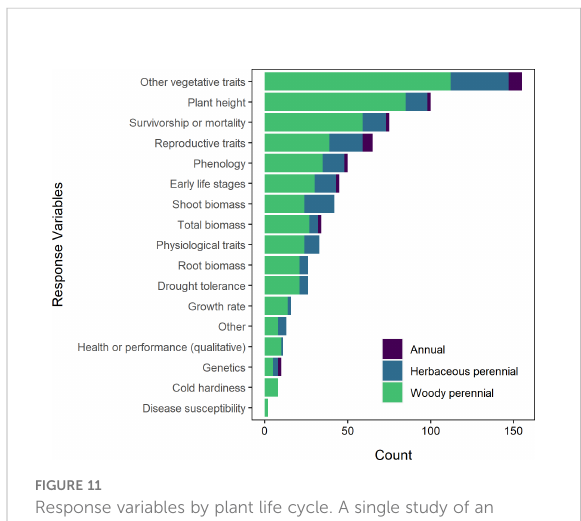
FIGURE 11 Response variables by plant life cycle. A single study of an herbaceous perennial is omitted from this visualization. “ Other vegetative traits ” consists of vegetative, morphological traits not listed separately (e.g., diameter, number of leaves, branching habit,